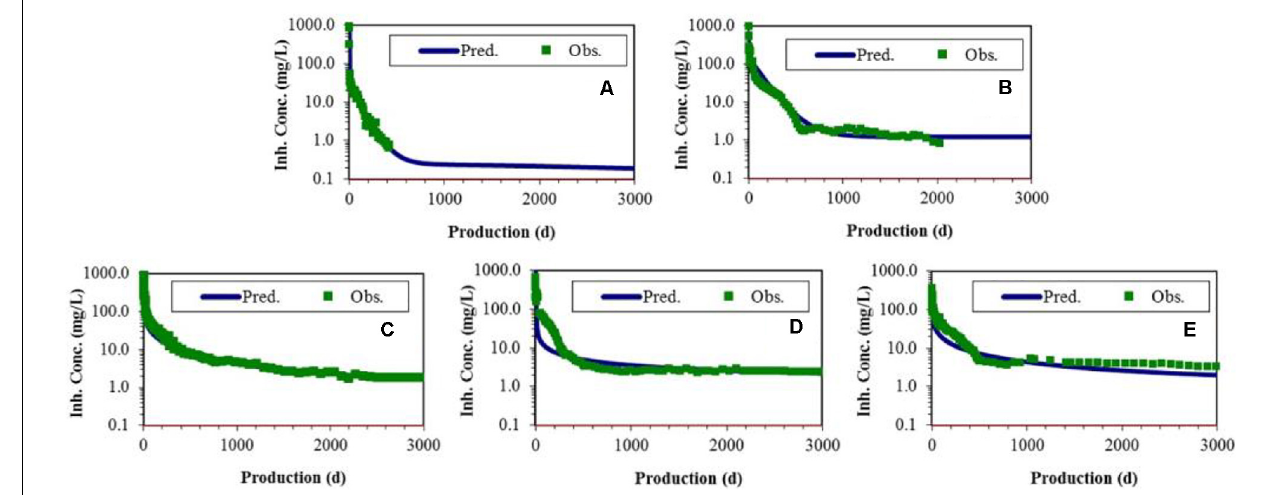
FIGURE 13 | Comparison of Ca-DTPMP inhibitor squeeze return data with SqueezeSoftPitzer model prediction. (A) DTPMP only inhibitor and in the presence of (B) Na 3 Cit, (C) CTAB, (D) Hyamine, and (E) Gemini. [Na + ] = 23,000 mg/L, [Ca 2 + ] = 1000 mg/L, [Cl - ] = 37,275 mg/L, total alkalinity = 915, TDS = 62,535 mg/L, pCO 2 = 1 bar, pH 5.6, assuming 1 PV = 1 production